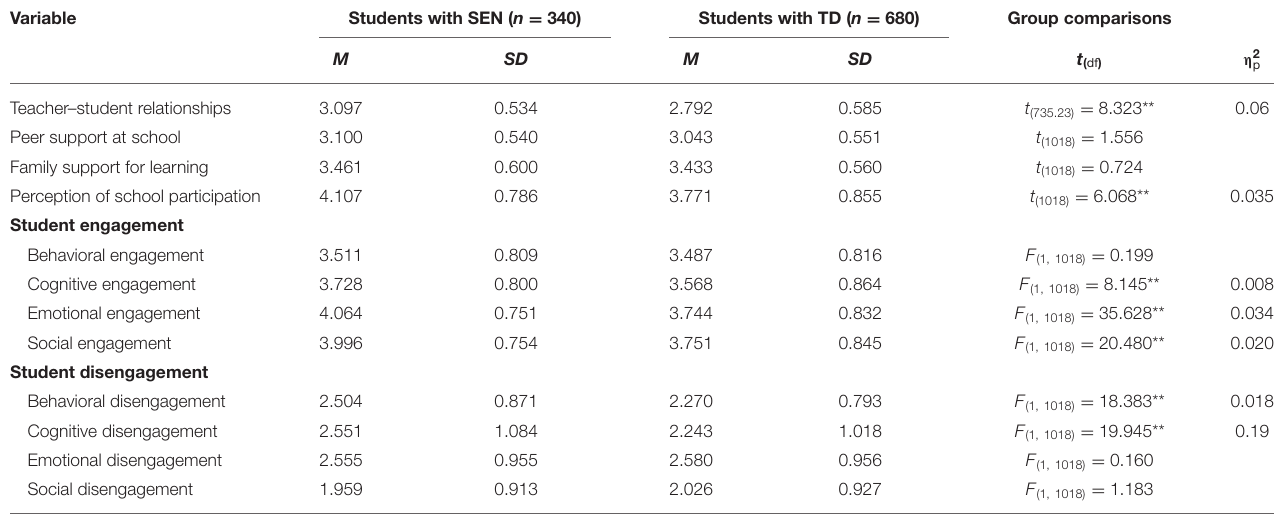
TABLE 1 | Mean, SD, t -tests, and effect sizes for teacher–student relationship, peer support at school, family support for learning and perception of school participation in students with SEN and